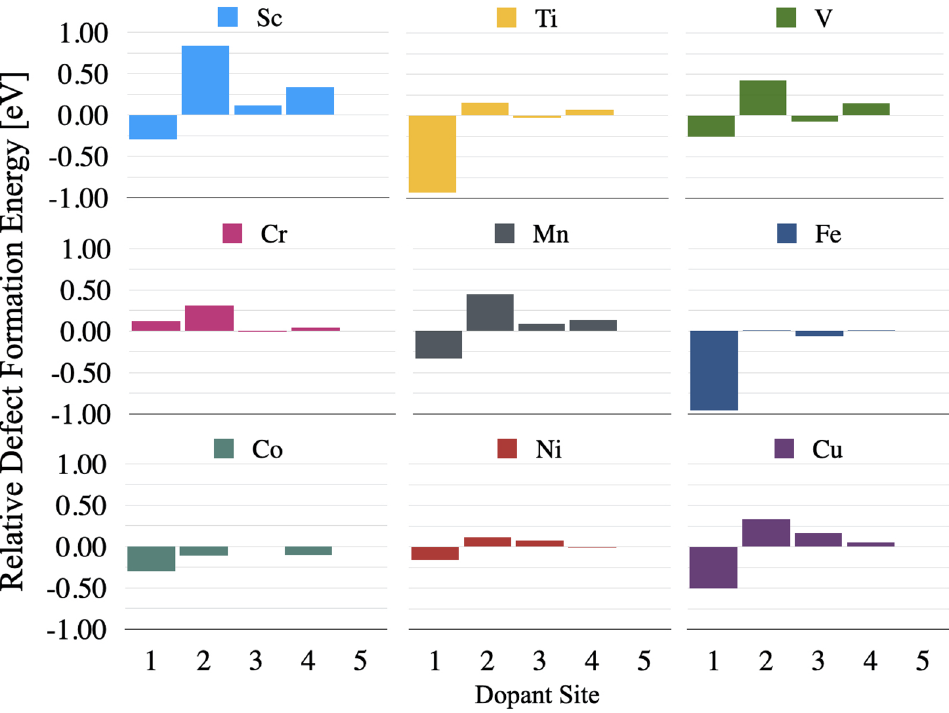
Figure 3. Defect formation energy, in eV, relative to bulk-like doping (position 5) for each respective dopant. Negative energies suggest the doping site is more stable than bulk-like doping, while positive energies suggest the doping site is less stable than bulk-like doping.